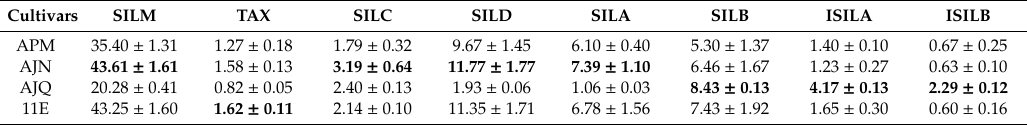
Table 8. Contents of SILM constituents of 4 French milk thistle